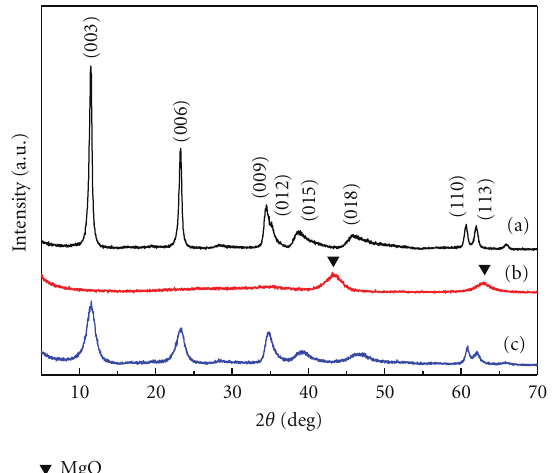
Figure 1: XRD patterns of (a) the original LDH, (b) MMO, and (c) FLDH.